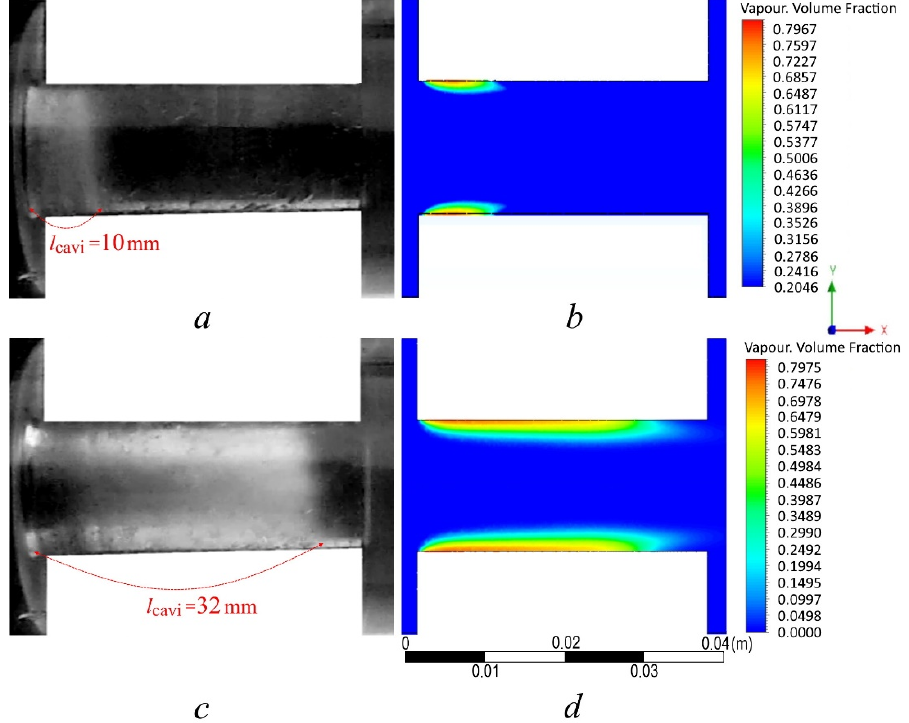
Figure 10. Numerical and experimental results. Cylindrical nozzle. ( a , b )—inlet pressure 2.5 atm, ( c , d )—inlet pressure 2.8 atm.